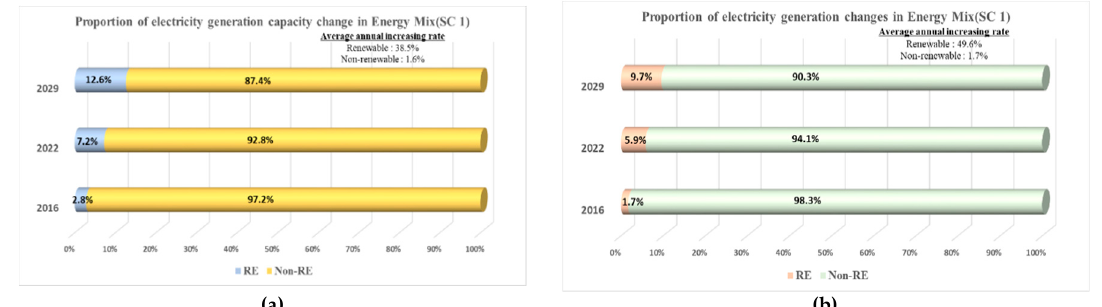
Figure 5. Newly installed capacity of each energy source in SC1.